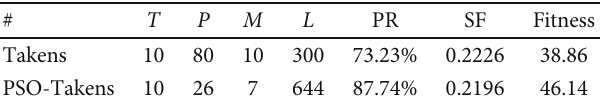
Table 1: Parameter changes of hip joint prediction algorithm under nonstandard gait data.